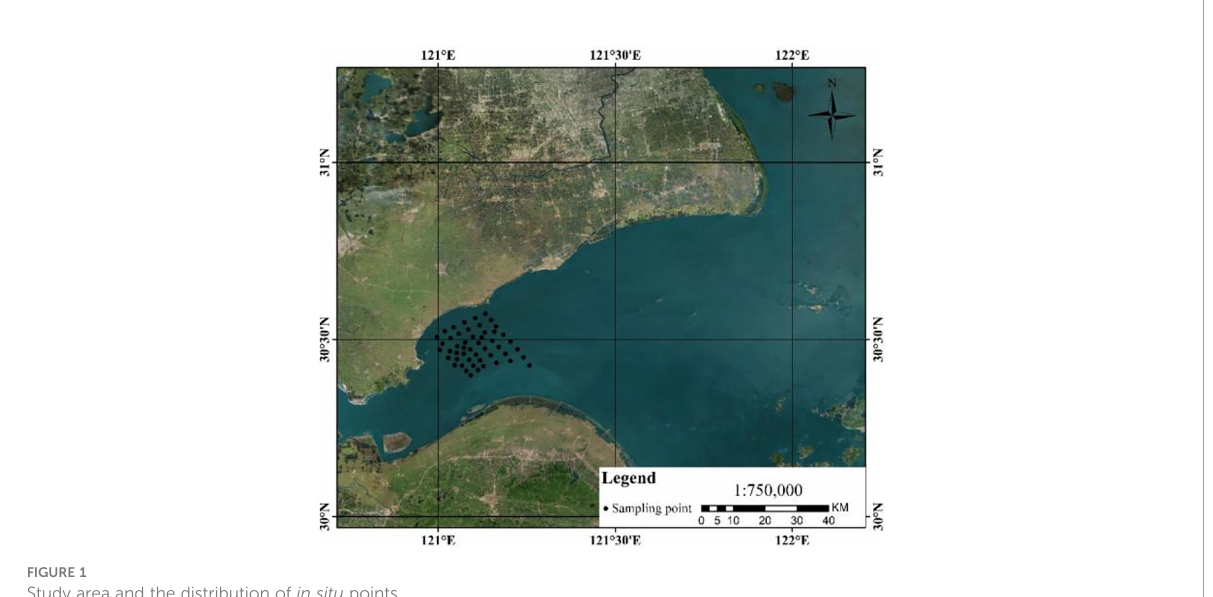
FIGURE 1 Study area and the distribution of in situ